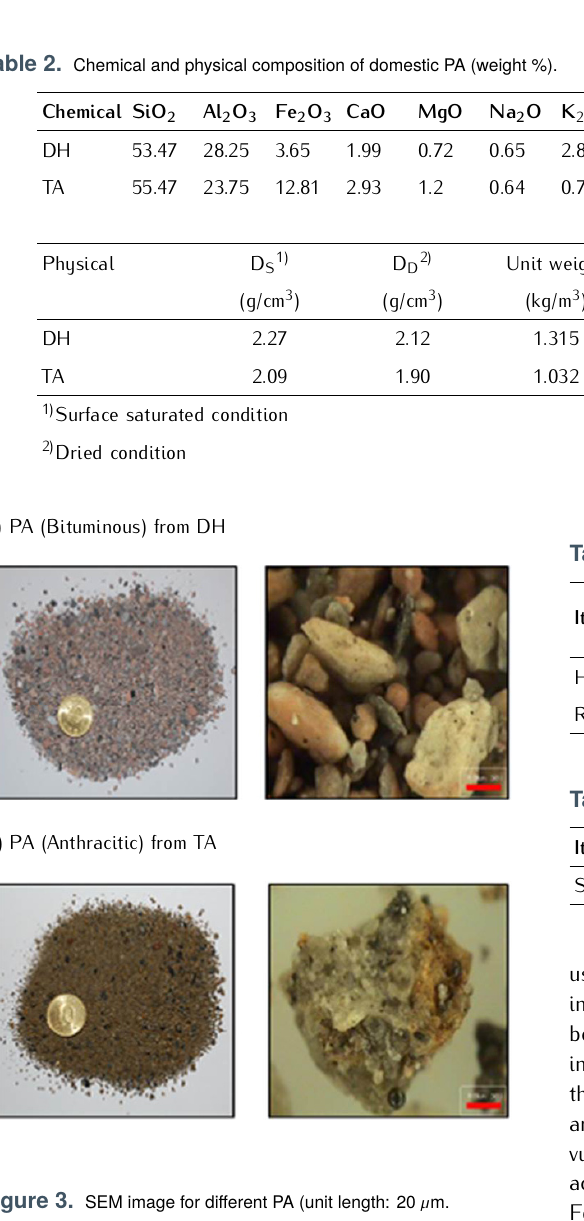
Figure 3. SEM image for different PA (unit length: 20 µ m.